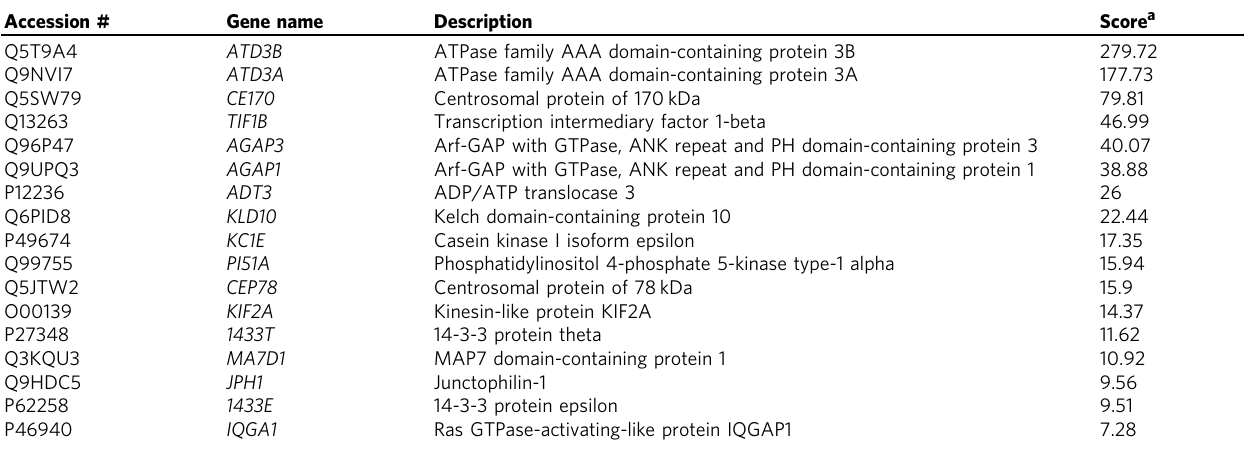
a Mascotscore:proteinscorere fl ectsthecombinedscoresofallobservedmassspectrathatcanbematchedtoaminoacidsequenceswithinthatprotein.Ahigherscoreindicatesamorecon fi